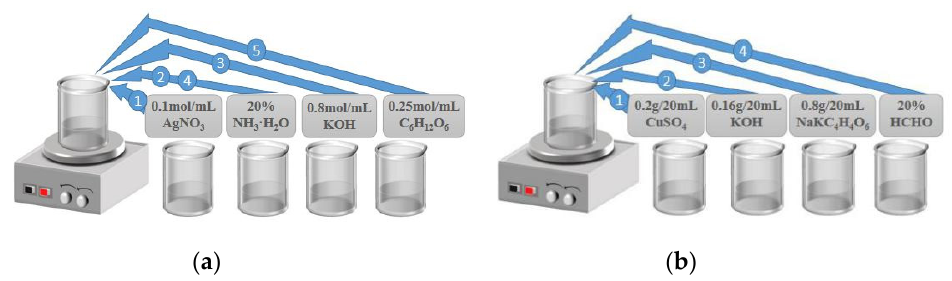
Figure 5. ( a ) Preparation process of reagent required for silver mirror reaction; ( b ) Preparation process of reagent required for bronze mirror